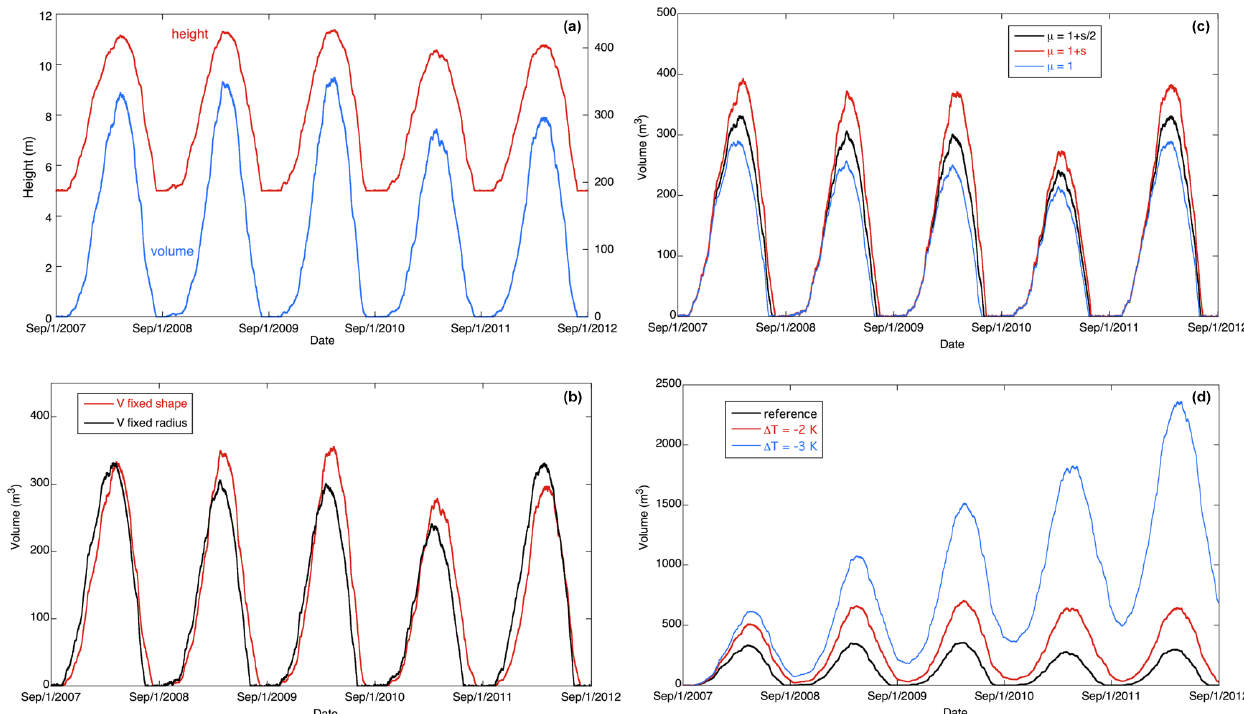
Figure 3. Calculated evolution of ice stupa for the case of unlimited water supply for five winters. (a) Height and volume for the case with an inner structure (height 5m) and fixed shape. (b) Volume for the case with an inner structure and the case with a fixed radius (7m). (c) The effect of the exposure parameter µ on the volume (fixed radius). (d) The effect of a negative temperature perturbation. For (cid:49)T = − 3K the stupa does not disappear anymore but is growing from year to year (fixed